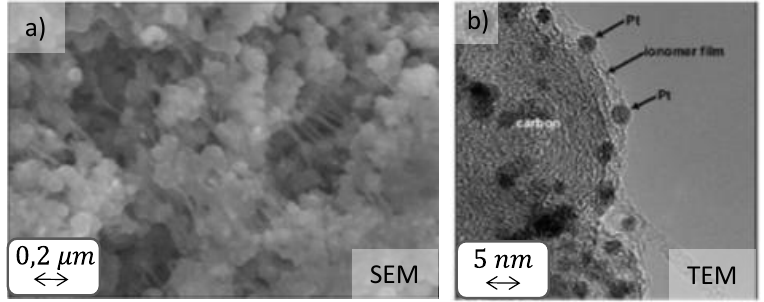
Figure 9. Detail of the active layer (AL) of an MEA: [22]. ( a ) Scanning Electron Microscopy (SEM) image | ( b ) Transmission Electron Microscopy (TEM) image.